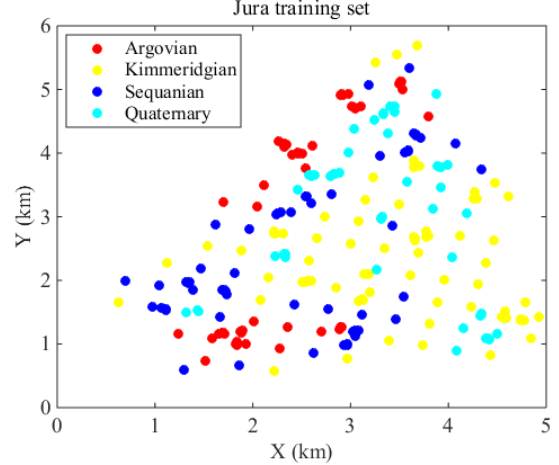
Figure 1. Jura lithology data set with four classes.